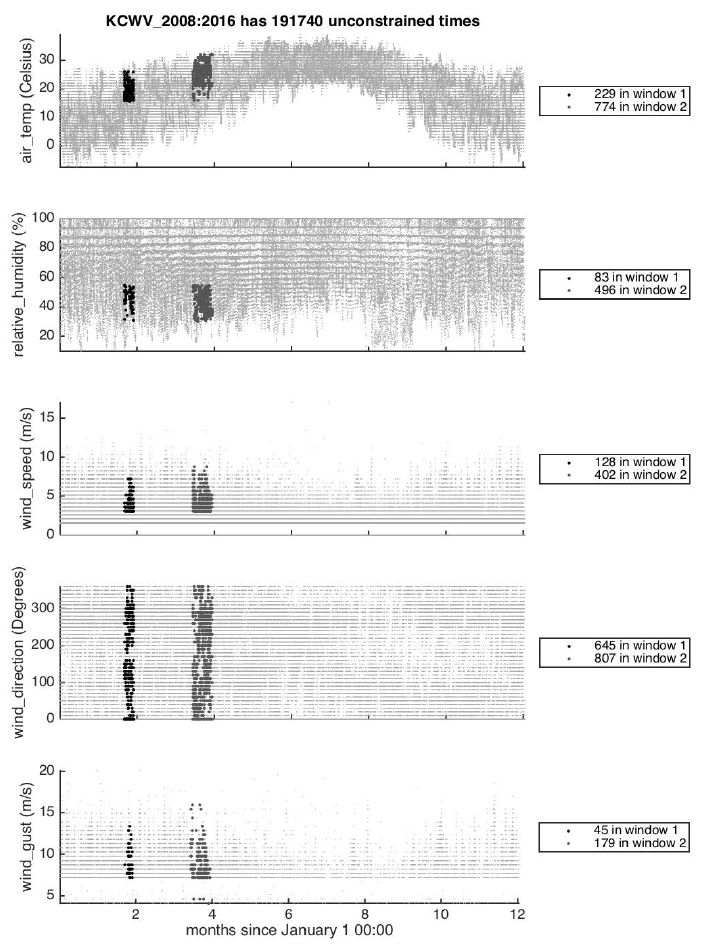
Figure A1. Station data (vertical) vs. month number (horizontal) for station KCWV (Claxton Evans County Airport, 32.19510° N, 81.86960° W 111 ft in Georgia) from 2008 to 2016 with 2 burn windows per year. Points that do and do not meet the burn-requirements (Table 2) are dark and light gray, respectively, and enumerated in the legends and titles, respectively. The abscissa is t ( mod 12 ) for all the years indicated in the